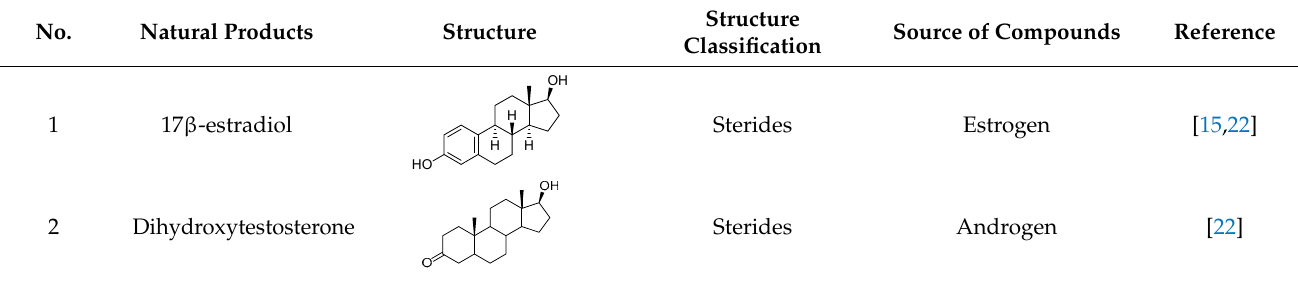
Table 2. Natural product targets 1–3.